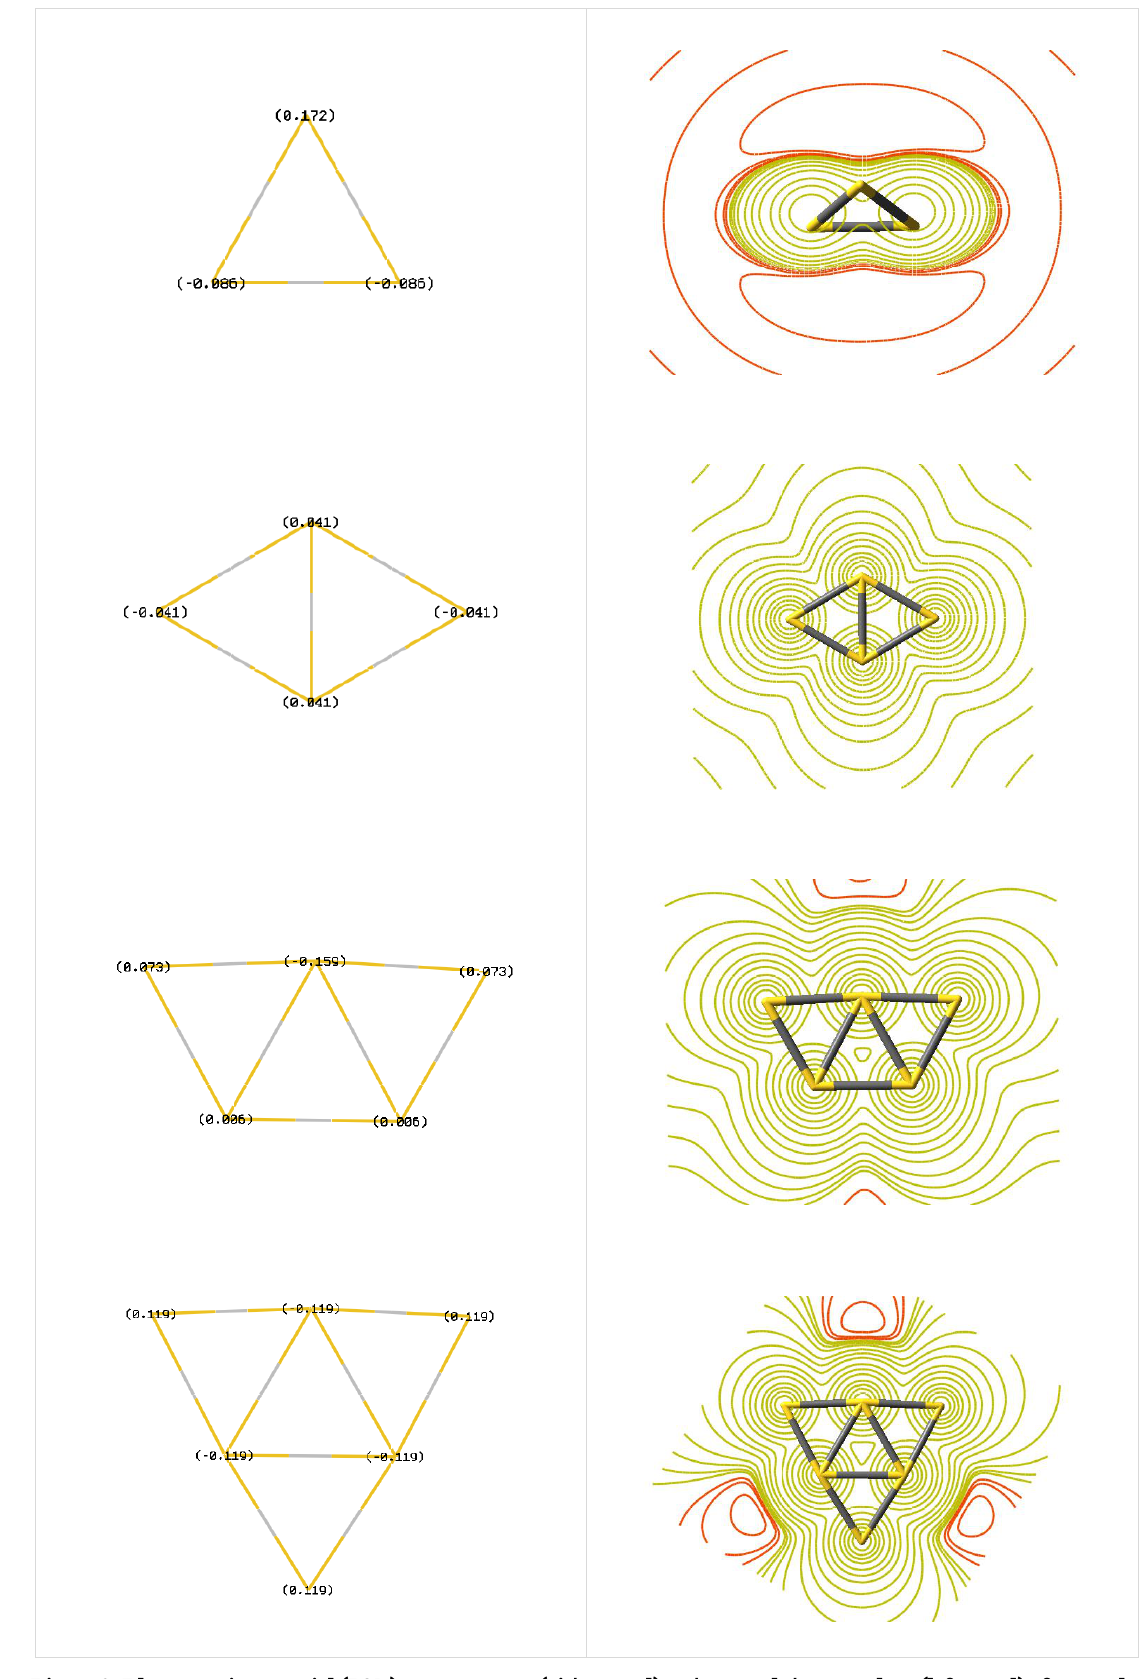
Figure 6. Electrostatic potential (ESP) contour maps (right panel) and natural charge values (left panel) of neutral gold clusters